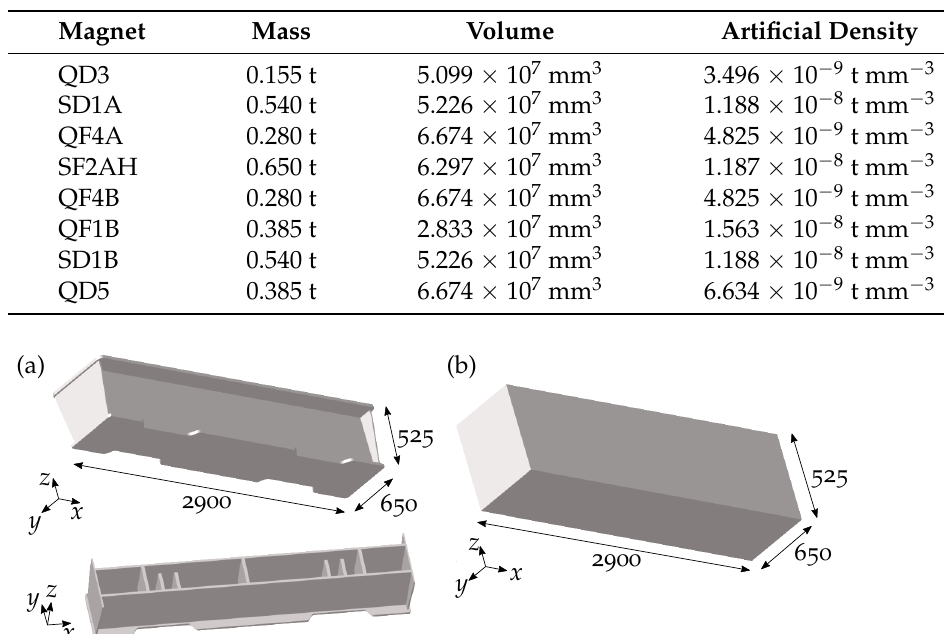
Figure 7. The PETRA III girder scaled in y -direction to 2900 mm length ( a ) and a box girder ( b ) that were both analysed in a parametric study. In ( a ), the lower figure shows the adapted PETRA III girder with hidden top surface to visualise the inner rib structure. All given dimensions are in